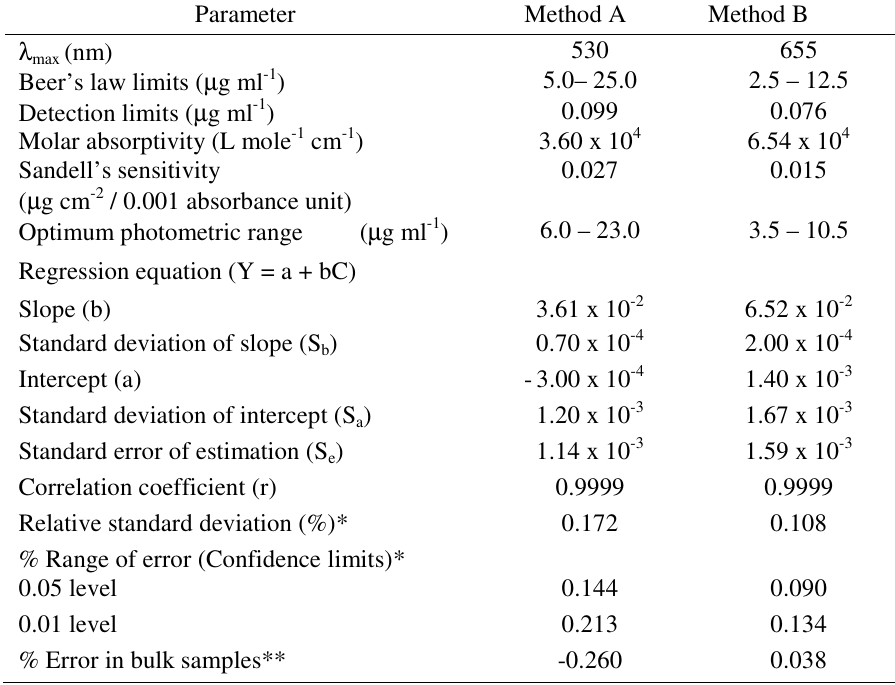
Table1 . Optical and regression characteristics, precision and accuracy of the proposed